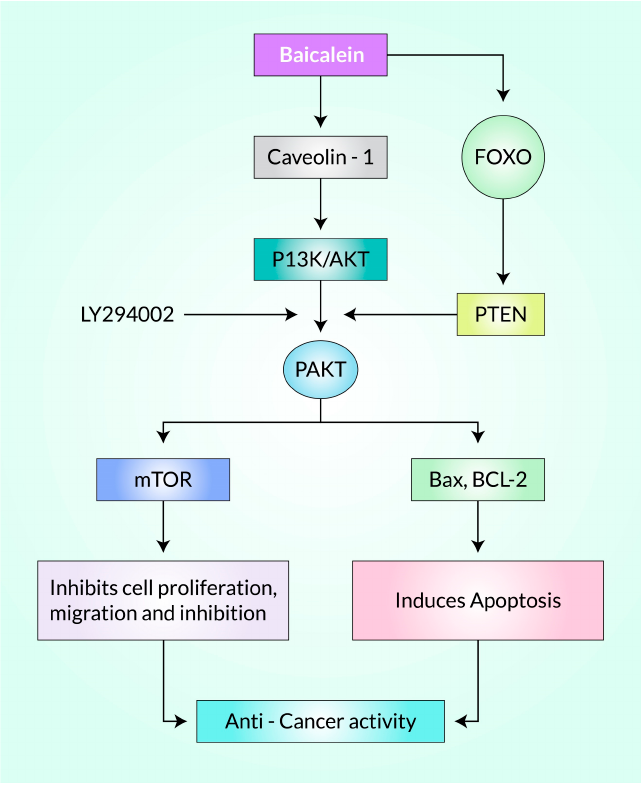
Figure 7. Baicalein inhibits cancer cell progression by targeting P13K/FOXO